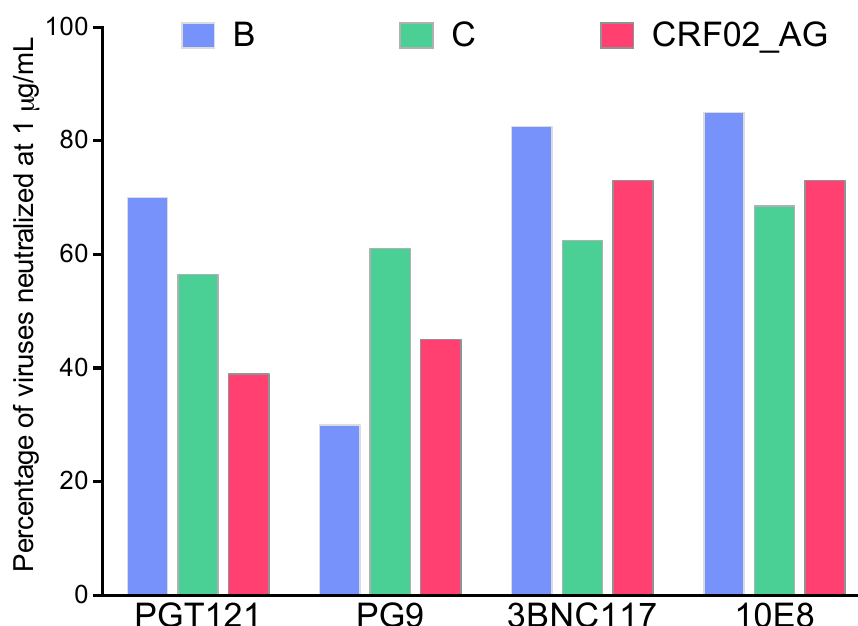
Figure 2. HIV-1 genetic diversity impacts its susceptibility to bnAbs. As an illustration, neutralization data were gathered for four bnAbs (PGT121, PG9, 3BNC117, and 10E8), each targeting a di ff erent site of vulnerability (V3g, V1V2g, CD4bs, and MPER, respectively), tested against three panels of transmitted-founder (T / F) viruses representing clade C ( n = 200) [60], B ( n = 40) [62], and CRF02_AG ( n = 33) [61]. Based on individual half-maximal inhibitory concentration (IC 50 ) values, the percentage of viruses neutralized at the bnAb concentration of 1 µ g / mL within each clade is represented and highlights intersubtype discrepancies of the neutralization